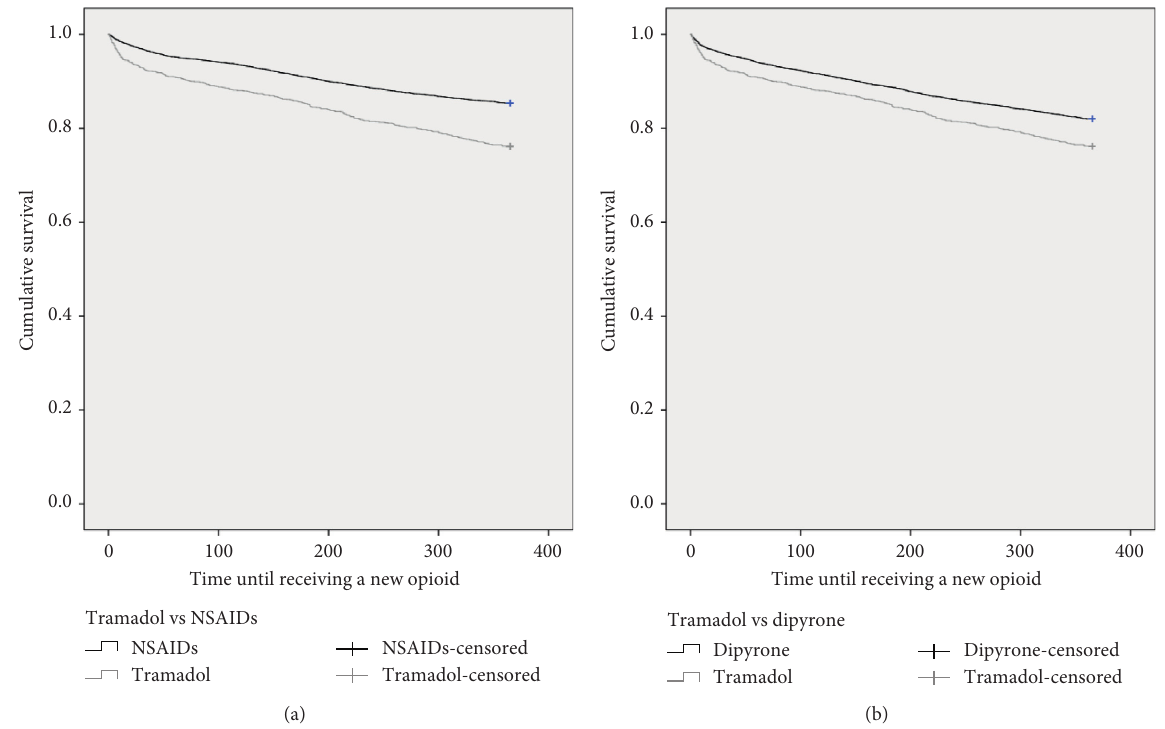
Figure 1: (a) Kaplan–Meier type analysis of the time until receiving a new opioid from the tramadol and NSAID patient cohorts at five clinics in Colombia, 2018-2019. (b) Kaplan–Meier type analysis of the time until receiving a new opioid from the tramadol and dipyrone patient cohorts at five clinics in Colombia,